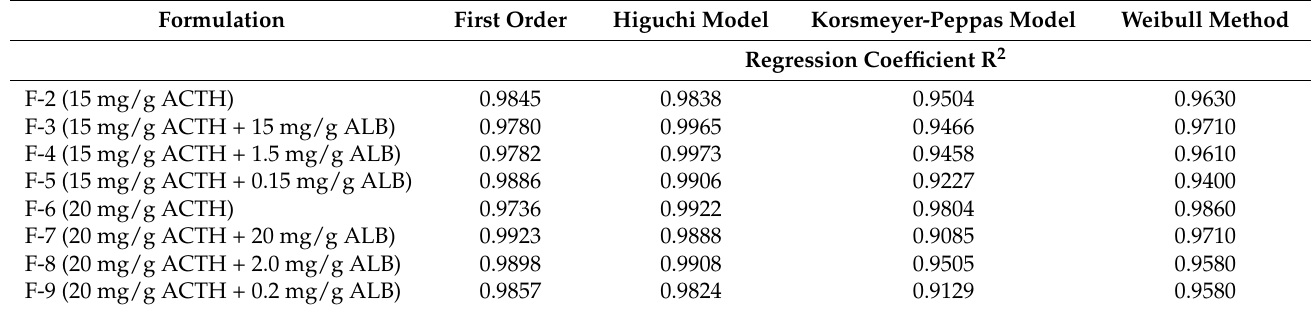
Table 3. Kinetic release models fitted to describe the release of ACTH from obtained hydrogel for formulations F-2–F-9. Formulation